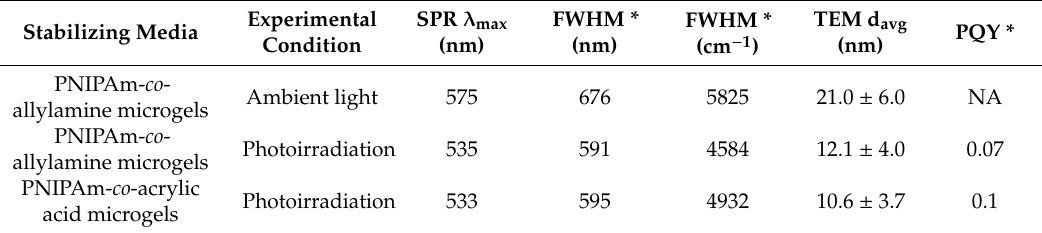
Table 1. Correlating absorption spectra (SPR) with a TEM-determined particle size (average diameter, d avg ) of gold nanoparticles (AuNPs) obtained from different compositions of poly( N -isopropylacrylamide) (PNIPAm) microgels.